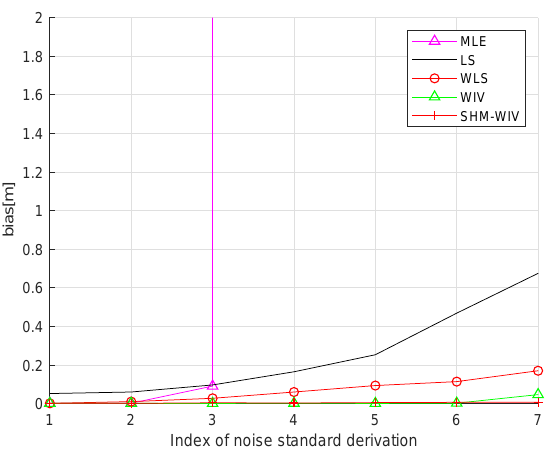
Figure 5. Bias versus noise with fixed source location.